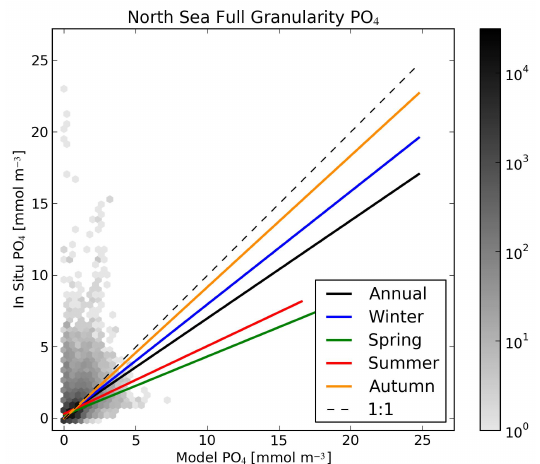
Fig. 6. Two-dimensional binned scatter plot of full granularity matched model data against in situ measurements for the North Sea nitrates. The solid coloured lines show the linear regression fits for the full annual and seasonal data, and the dashed line is the line of unity slope that passes through the origin. The shading of the binned data density plot is scaled such that darker hue indicates logarithmi- cally higher data density.